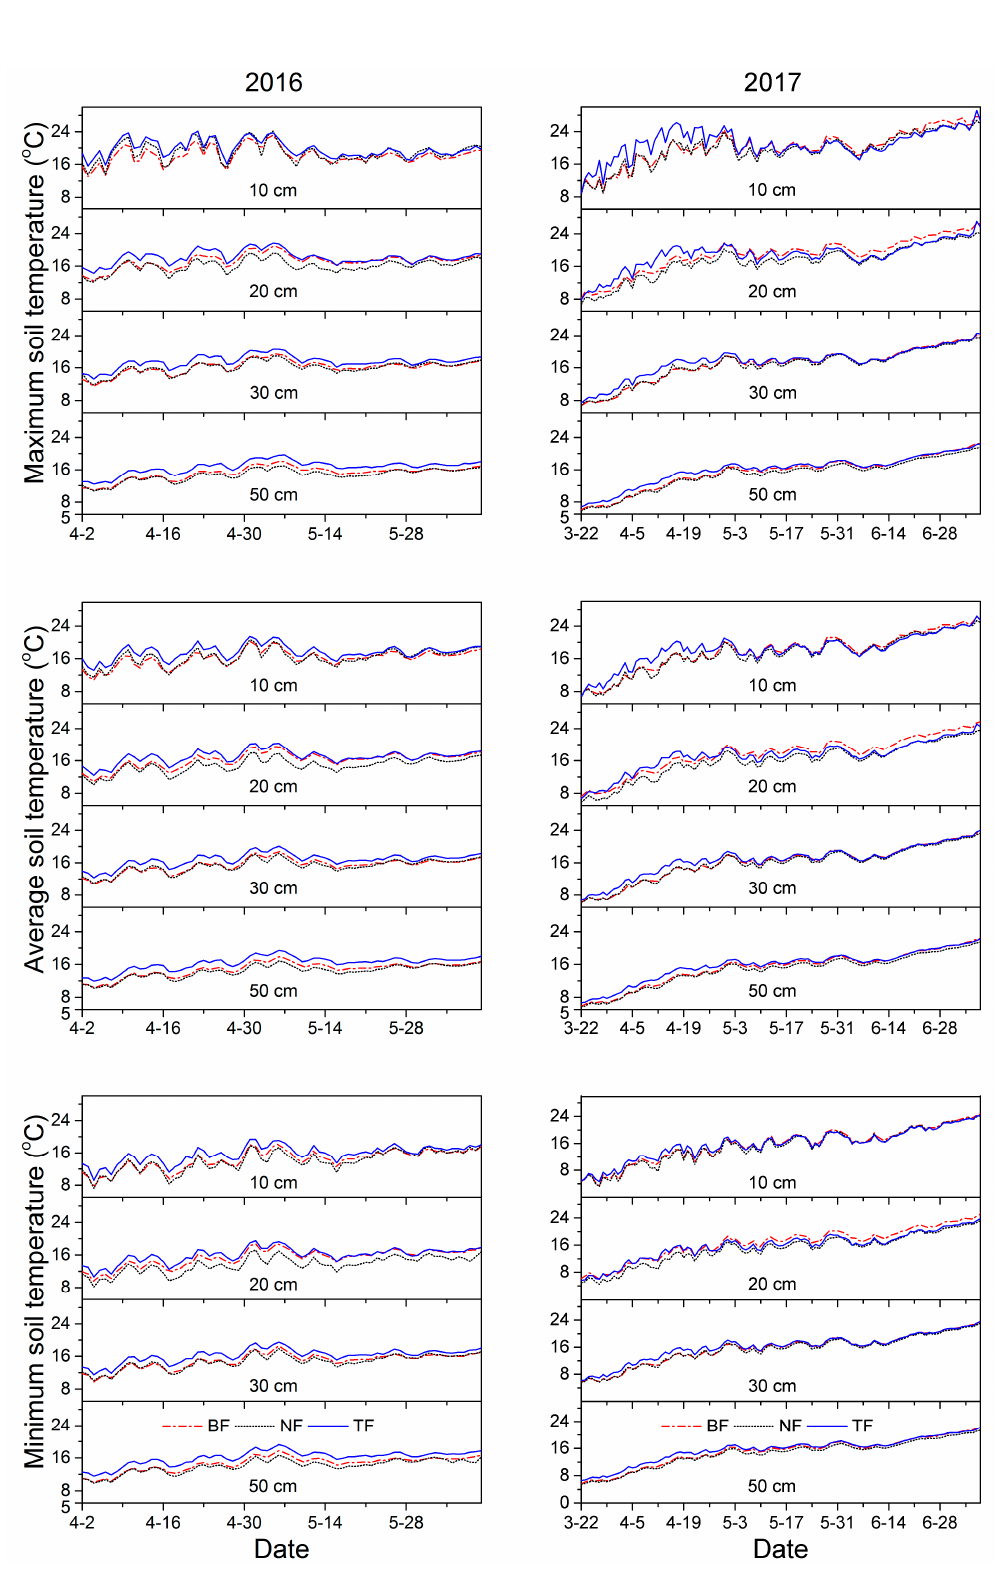
Figure 5. Seasonal variations of the daily maximum soil temperature, daily average soil temperature, and daily minimum soil temperature at 10–50 cm soil depths for different mulch treatments: black film (BF), no film (NF), and transparent film (TF) in 2016 and 2017.